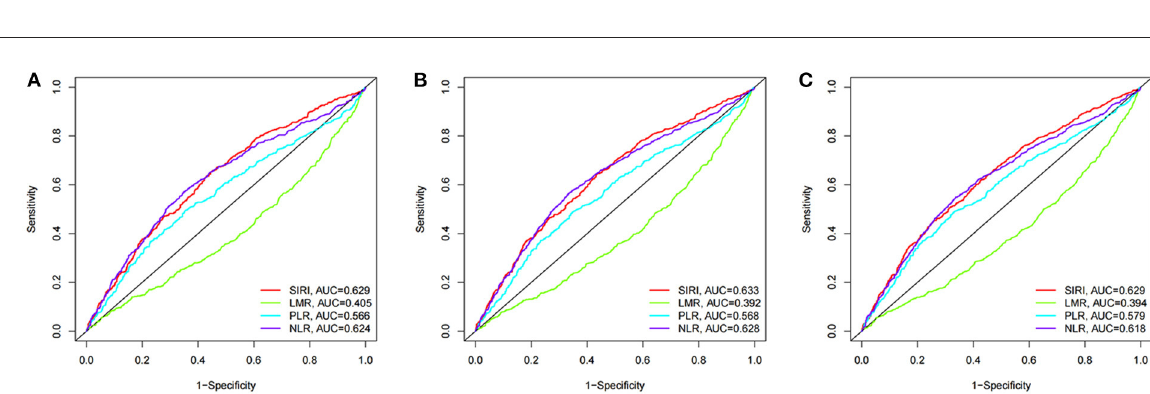
The SIRI, which combines three inflammatory